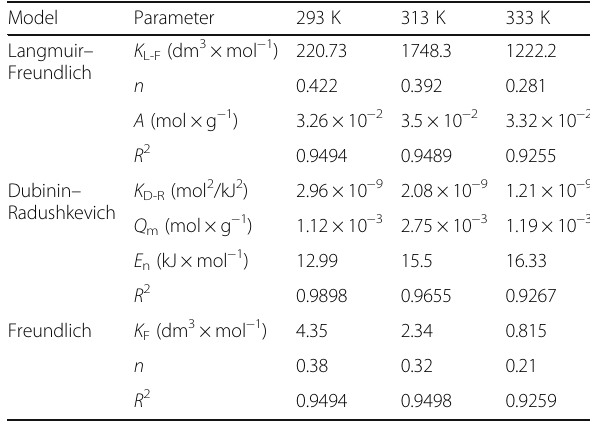
Table 5 Parameters of the isotherm models for the adsorption of U(VI) ions on the